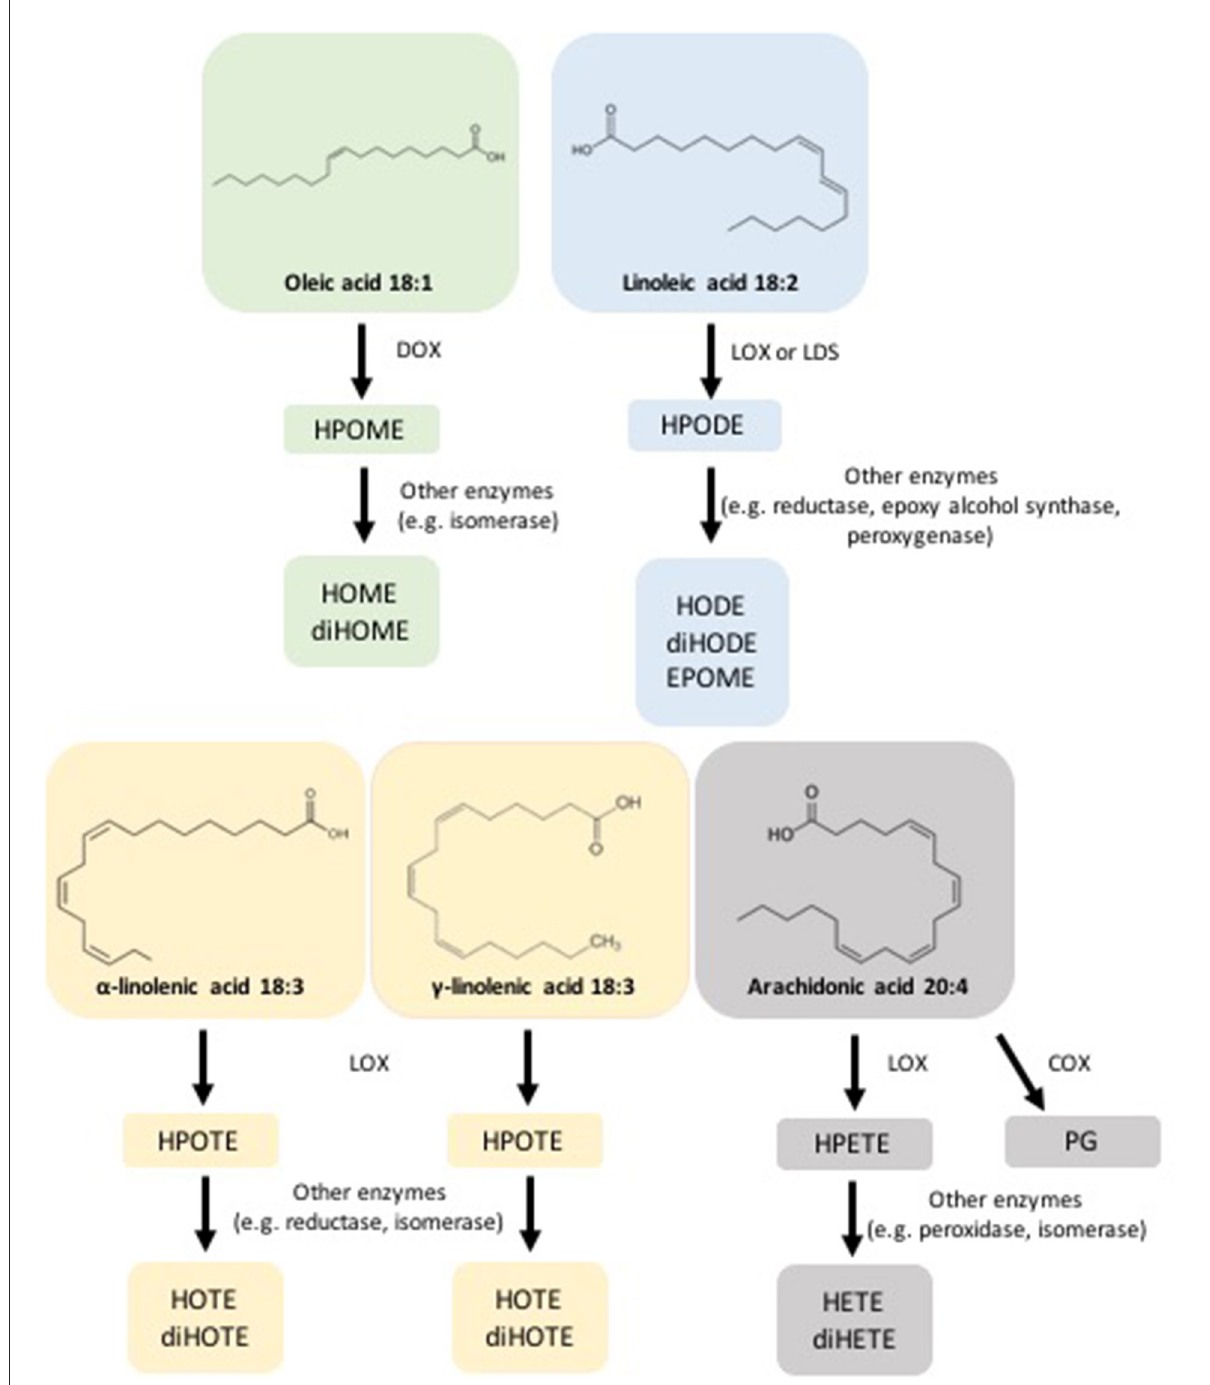
FIGURE1 Fungal oxylipins. Oleic acid (18:1) can be oxidized by LDS enzyme and converted in hydroperoxyoctanoic acid (HPOMEs); other enzymes (e.g. isomerases) convert HPOME in hydroxyoctanoic acid (HOME), and di-hydroxyoctanoic acid (diHOME). Linoleic acid (18:2) can be oxidized by LOX enzyme and converted in hydroperoxyoctadecadienoic acid (HPODE); other enzymes (e.g. reductases) convert HPODE in hydroxyoctadecadienoic acid (HODE), and di-hydroxyoctadecadienoic acid (diHODE). Linoleic acid (18:2) is also the substrate of LDS that catalyzes the conversion in hydroperoxyoctadecadienoic acid (HPODE); other enzymes (e.g. epoxidases) convert HPODE